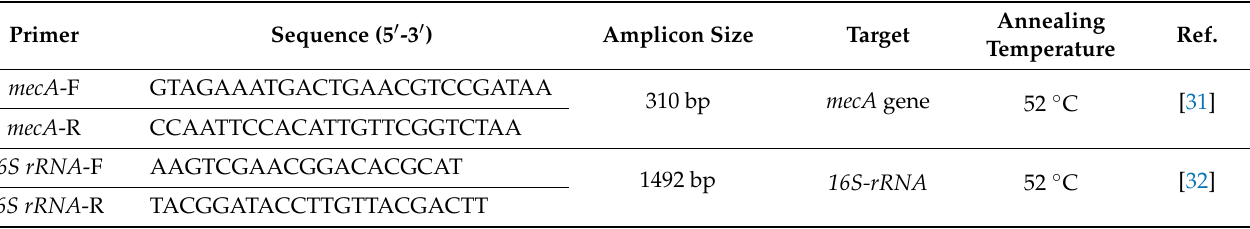
Table 1. List of primers with annealing temperatures and expected size of amplicons in this study.